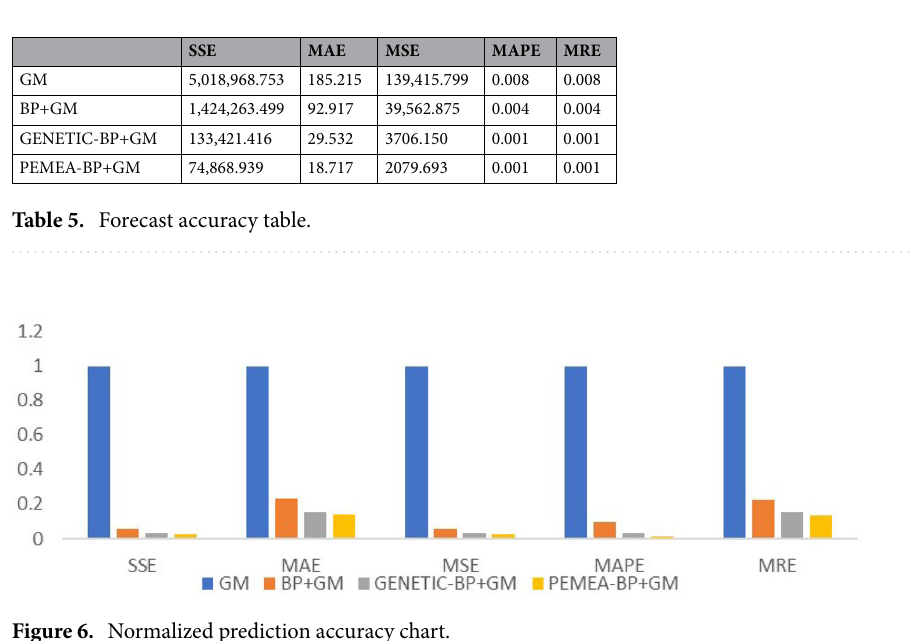
Figure 6. Normalized prediction accuracy